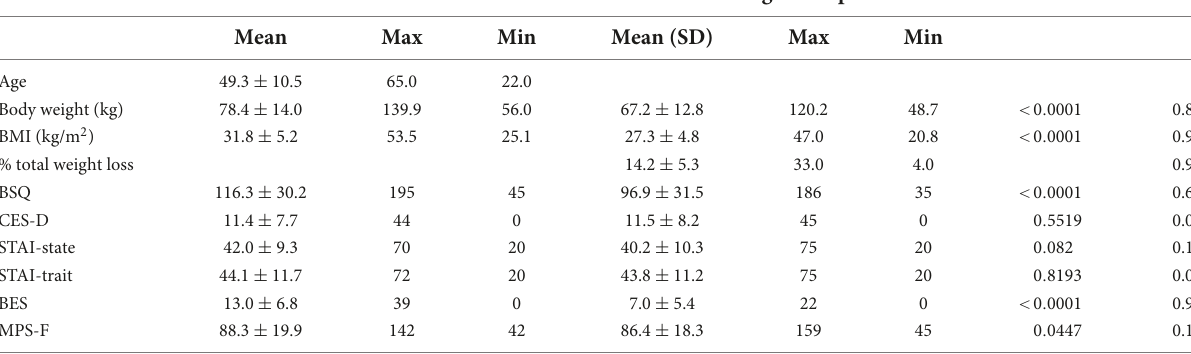
TABLE 1 Changes in clinical data from before to after the weight loss phase.